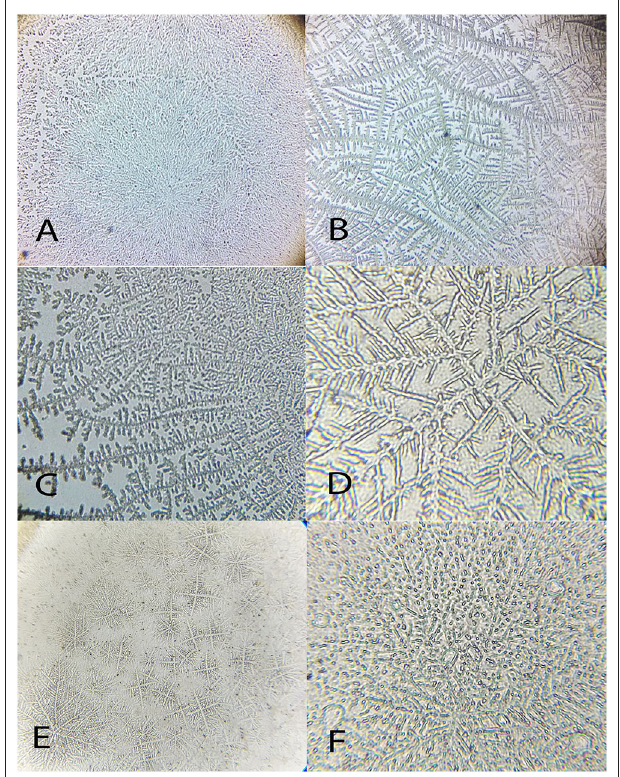
FIGURE 9 | Examples of Chelonoides carbonaria tear ferning patterns, according to the Rolando and Masmali grading scales. (A) Type I (Rolando scale) grading 0 (Masmali scale); (B) Type II (Rolando scale), grading 1 (Masmali scale); (C) Type III (Rolando scale), grading 3 (Masmali scale); (D) Type III (Rolando scale), grading 3 (Masmali scale); (E) Type IV (Rolando scale), grading 3 (Masmali scale). (F) Grading 4 (Masmali